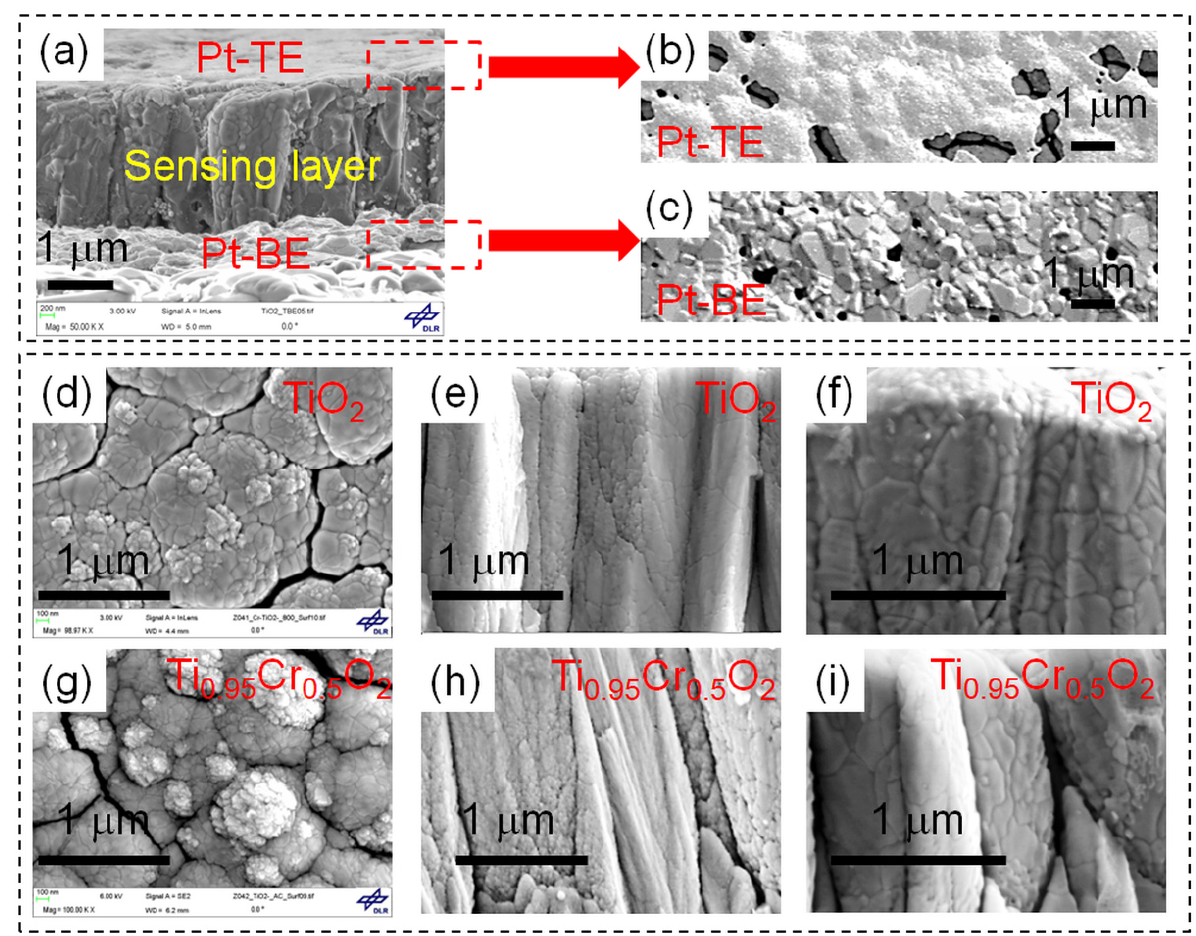
Figure 3. The scanning electron microscope (SEM) analysis of both the coatings. The cross-sectional micrograph of the Pt/TiO2/Pt structure ( a ) along with surface topography of Pt-TE ( b ) and Pt-BE ( c ). The surface topographical and cross- sectional micrographs of the pristine TiO 2 sensing layer ( d – f ) and Ti 0.95 Cr 0.5 O 2 ( g – i ) sensing layer deposited on corundum [0006] substrate and annealed at 800 ° C. The color mapping of the various elements (Pt, Ti, O and Cr), showing the Cr incorporation into the TiO 2 sensing